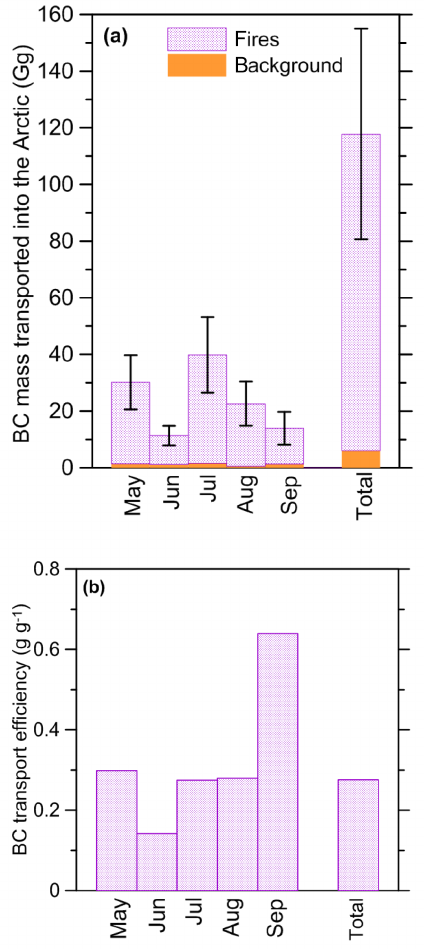
Figure 16. (a) The estimates of the BC mass (in Gg) transported from the study region across the polar circle into the Arctic along with (b) the corresponding estimates of the BC transport efficiency (see Sect.